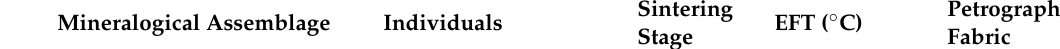
Table 4. Summary of the mineralogical fabrics defined by PXRD analysis for each meaningful chemical group. n : number of individuals. EFT: equivalent firing temperature. PE : Individual observed by petrography. (*): observations made on individual DOV002 (not included in the present paper; see Miguel 2014). *: Individual observed by SEM ( n = 11). IV: initial vitrification; Vc −